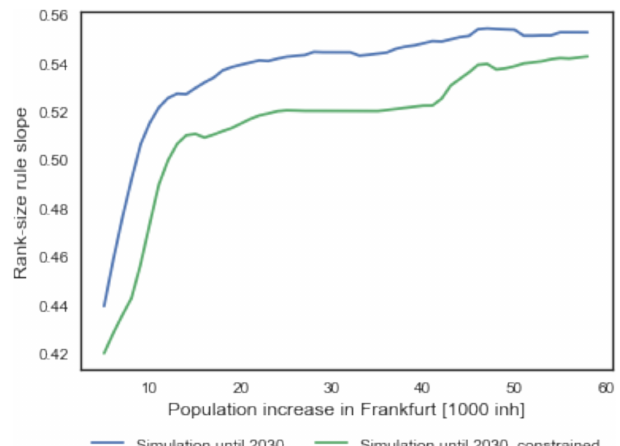
Figure 6. Moving average (five model steps) of the slope of the rank–size rule along the model runs minimizing the energy con- sumption for urban mobility in Frankfurt.